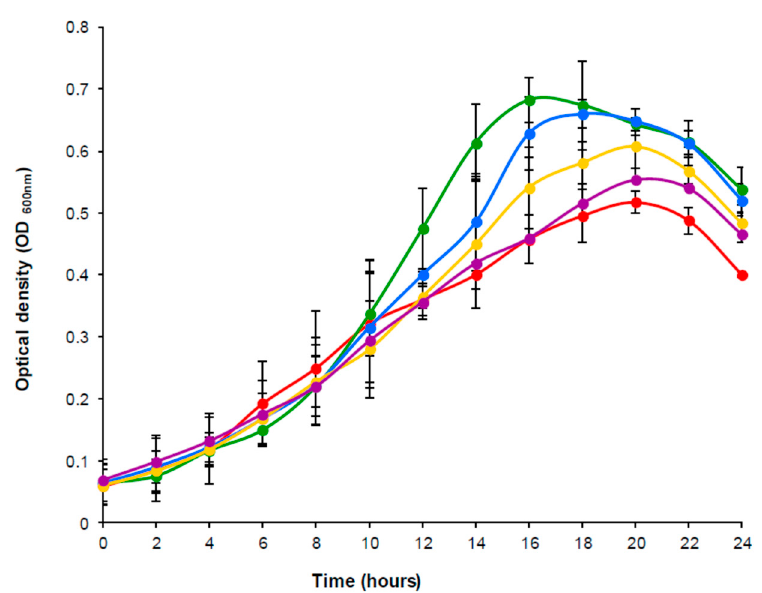
Figure 1. Growth kinetic curves of A. equolifaciens DSM19450 T grown in the presence of 50 µ M (green), 100 µ M (blue), 150 µ M (yellow) and 200 µ M (purple) of daidzein as compared to a control culture without daidzein (red).